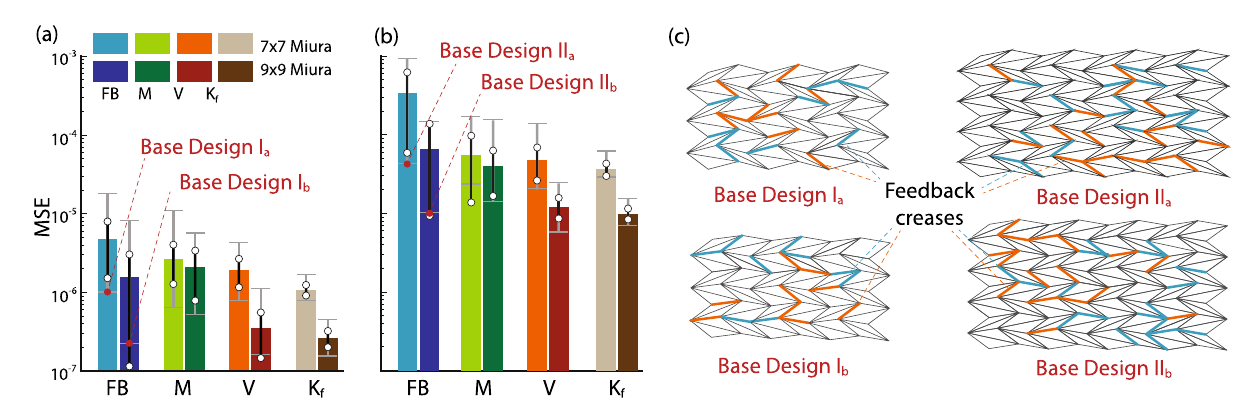
Figure 7. Effect of reservoir size and material properties on the reservoir computing performance. ( a ) The distribution of MSE from the Quadratic limit cycle simulations using random feedback crease distributions and different design parameter distributions. Here “FB” stands for feedback crease distribution, “M” stands for nodal mass distribution, “V” stands for origami vertices geometry perturbation, and “ K f ” stands for crease torsional stiffness distribution. It is worth emphasizing that the “FB” results come from one parametric study of 72 unique designs, and the “M,” “V,” and “ K f ” are results of the subsequent simulation. The bar charts depict the average value, standard deviation (circles), and extreme values (horizontal bars) of MSE. ( b ) A similar result from the Van der Pol limit cycle generation task. ( c ) The feedback crease distributions of the four different baseline designs used in this parametric